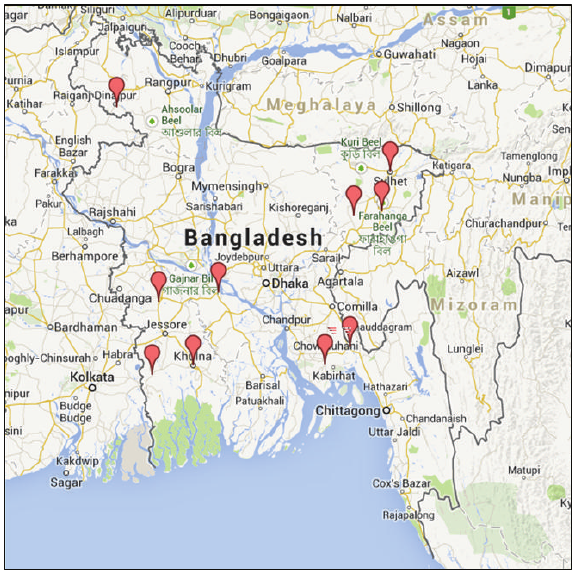
Figure 1: Collection sites for rice